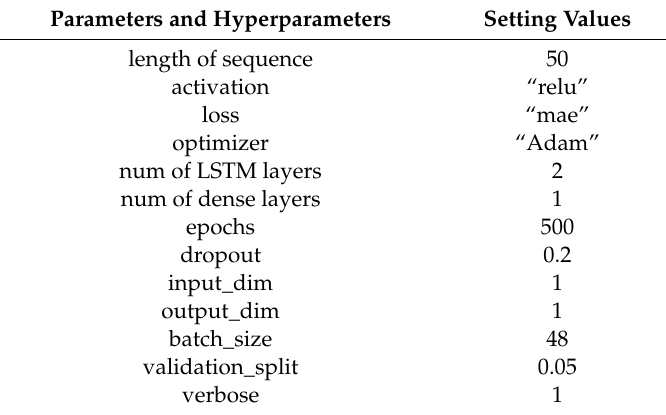
Table 1. Parameters and hyperparameters of LSTM.